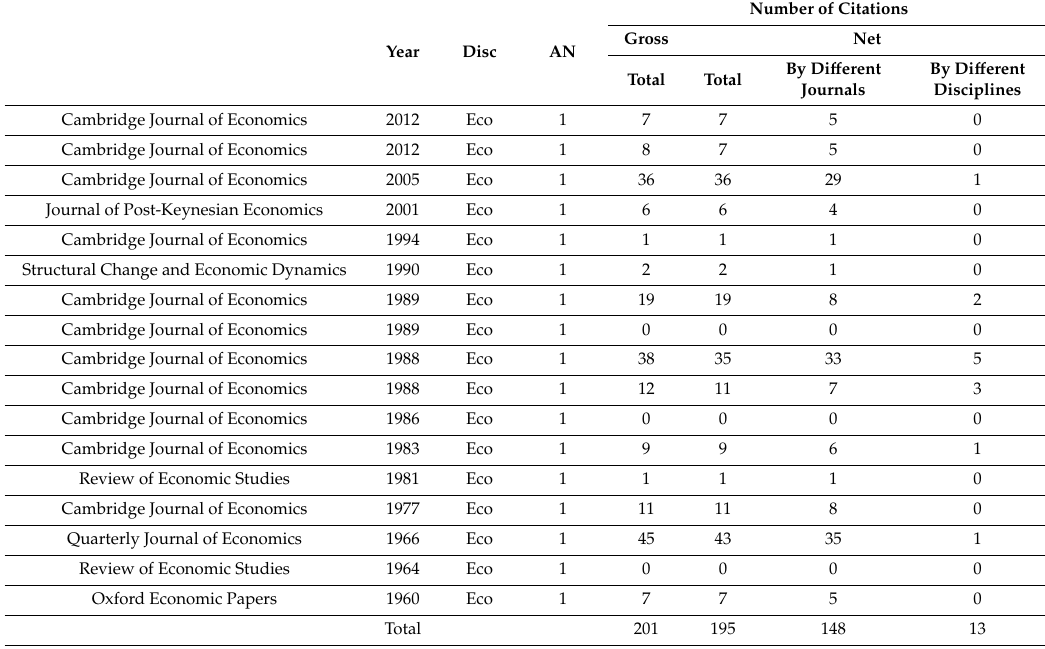
Table A3. Descriptive statistics and Scopus categories for the second analyzed PH, which is a representative intradisciplinary and intratopical heterodox PH. Each row represents a single publication; multiple publications in the same journal and same year are represented by separate rows.